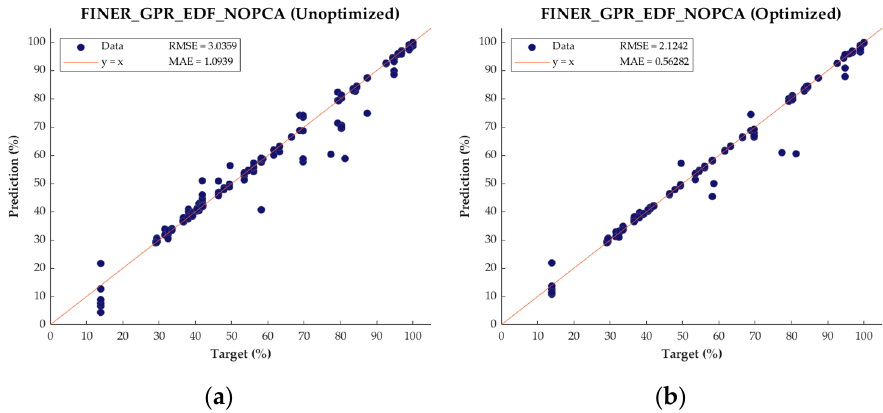
Figure 12. Visualization of EDF model optimization e ff ect by tuning the GPR algorithm hyperpa- rameters for target class percent fi ner than 0.075 mm sieve (FINER model); ( a ) predicted vs. actual plot for unoptimized GPR algorithm; ( b ) predicted vs. actual plot for optimized GPR.